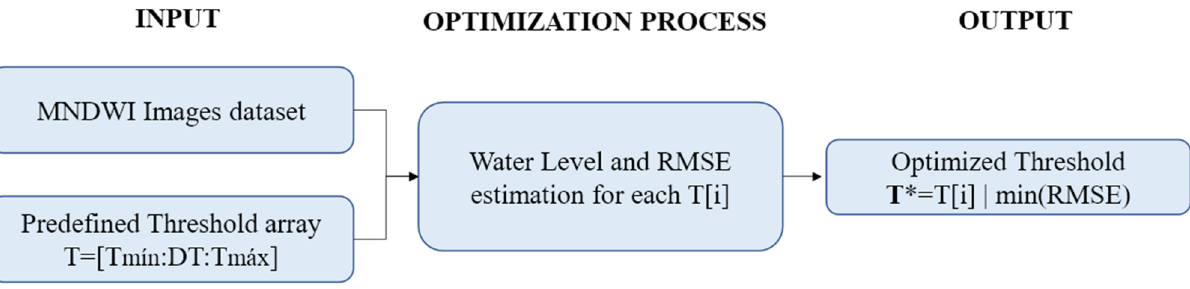
Figure 3. The optimization process ran over a selected images dataset and a predefined threshold array to find T*, which minimizes RMSE.